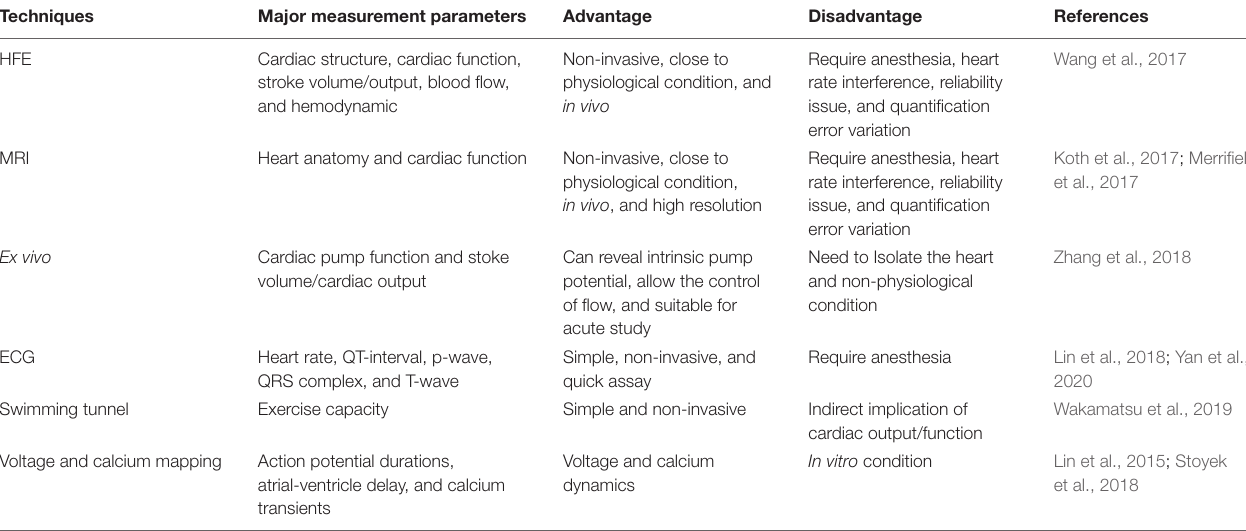
TABLE 2 | Emerging phenotyping techniques for adult zebrafish